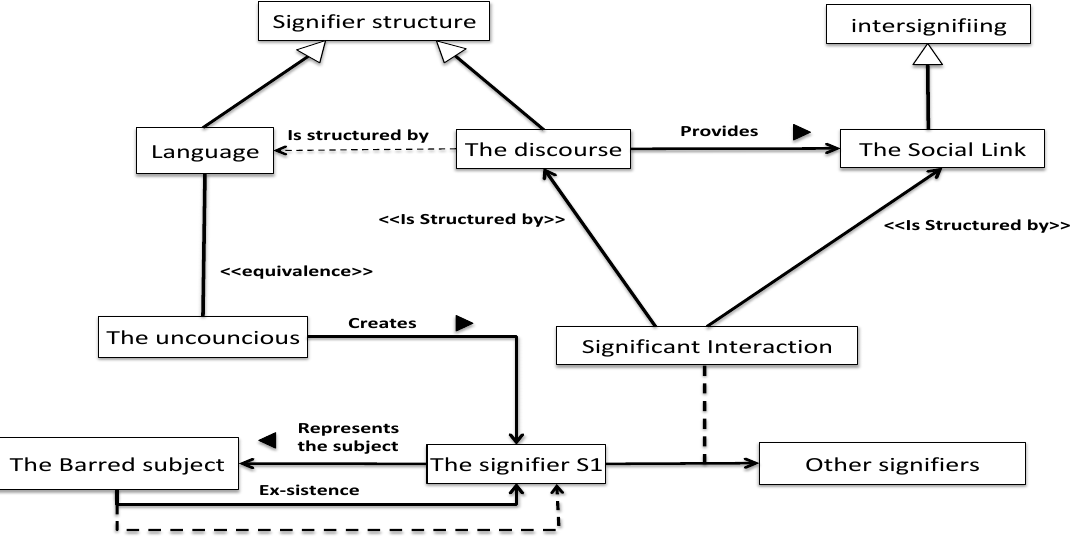
Figure 18. “The signified” Unified Modeling Language (UML) diagram Tr. into english from (Lamareille 2009) [62].